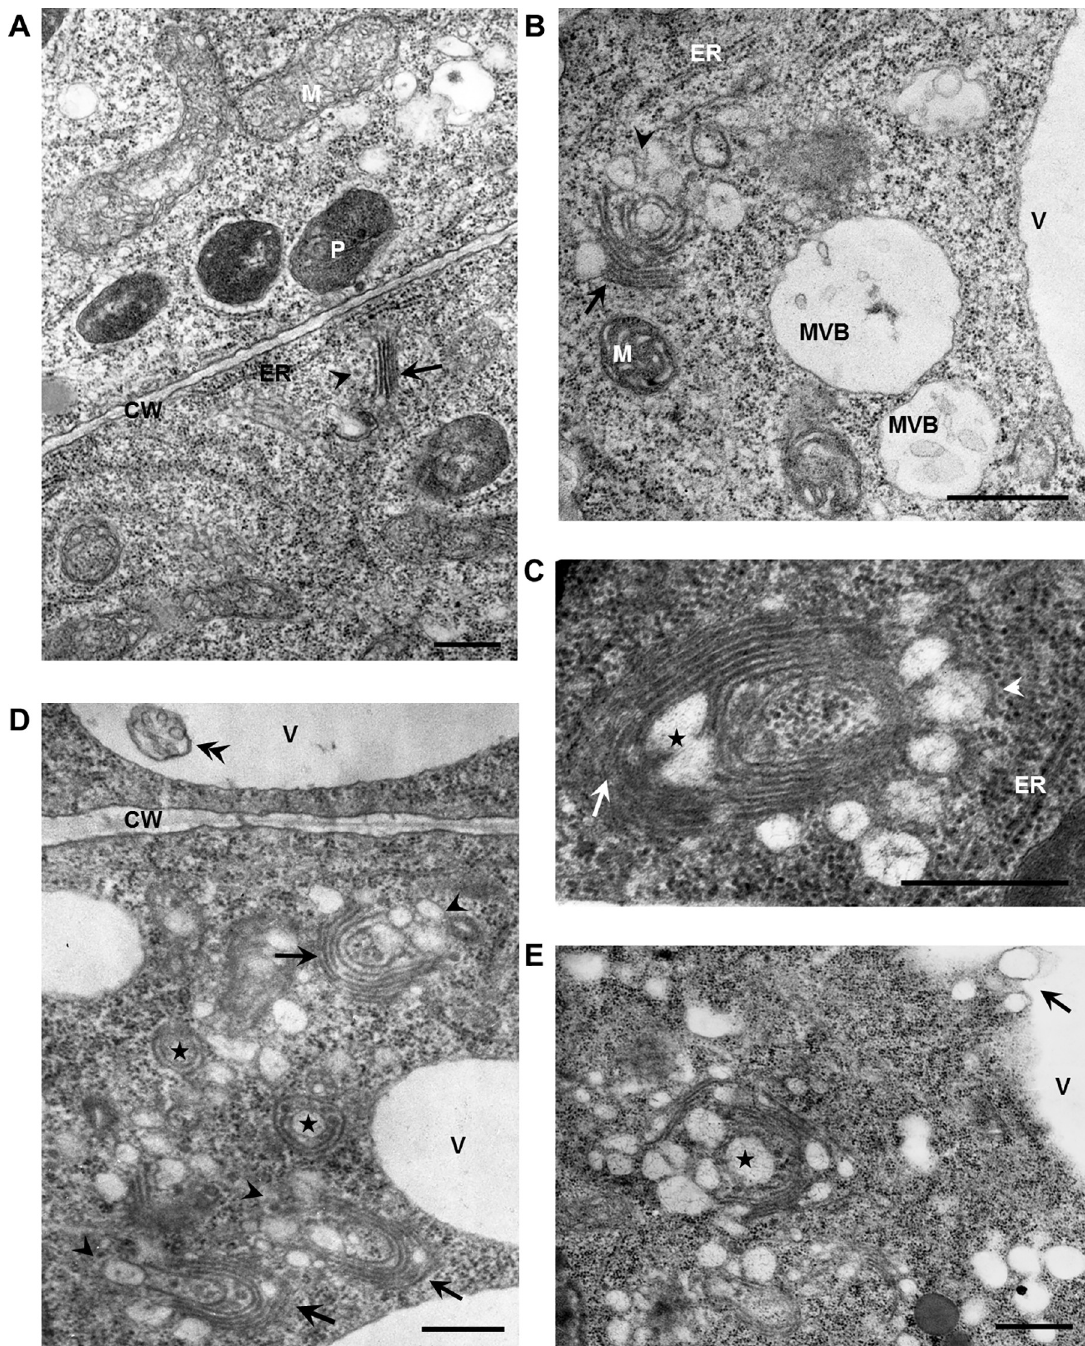
Fig 5. ES2 affects the Golgi apparatus. In control root epidermal cells, the Golgi apparatus consists of stacks of a few flattened, straight cisternae (A). ES2 causes accumulation of enlarged vesicles near the Golgi (B) and even in Golgi stacks (asterisk in C), Golgi stack expansion, bending, circulation (B-D), and separation of encircled Golgi cisternae (asterisks in D). Aberrant Golgi units congregate (D), and further degrade so that large compartments composed of a heterogeneous mixture of multi-lamellar structures and vesicles (asterisks in E) are visible in the cytoplasm (E). Arrows in A-D point to Golgi cis face and arrowheads to trans-face. Note the formation of multi-vesicular bodies in the vicinity of aberrant Golgi (B), their appearance in the vacuole (double arrowhead in D), and the release of vesicle complexes to vacuoles (arrow in E). M = mitochondria, MVB = multivesicular body, CW = cell wall, V = vacuole, ER = endoplasmic reticulum, P = plastid. Bars = 0.5 μ m.